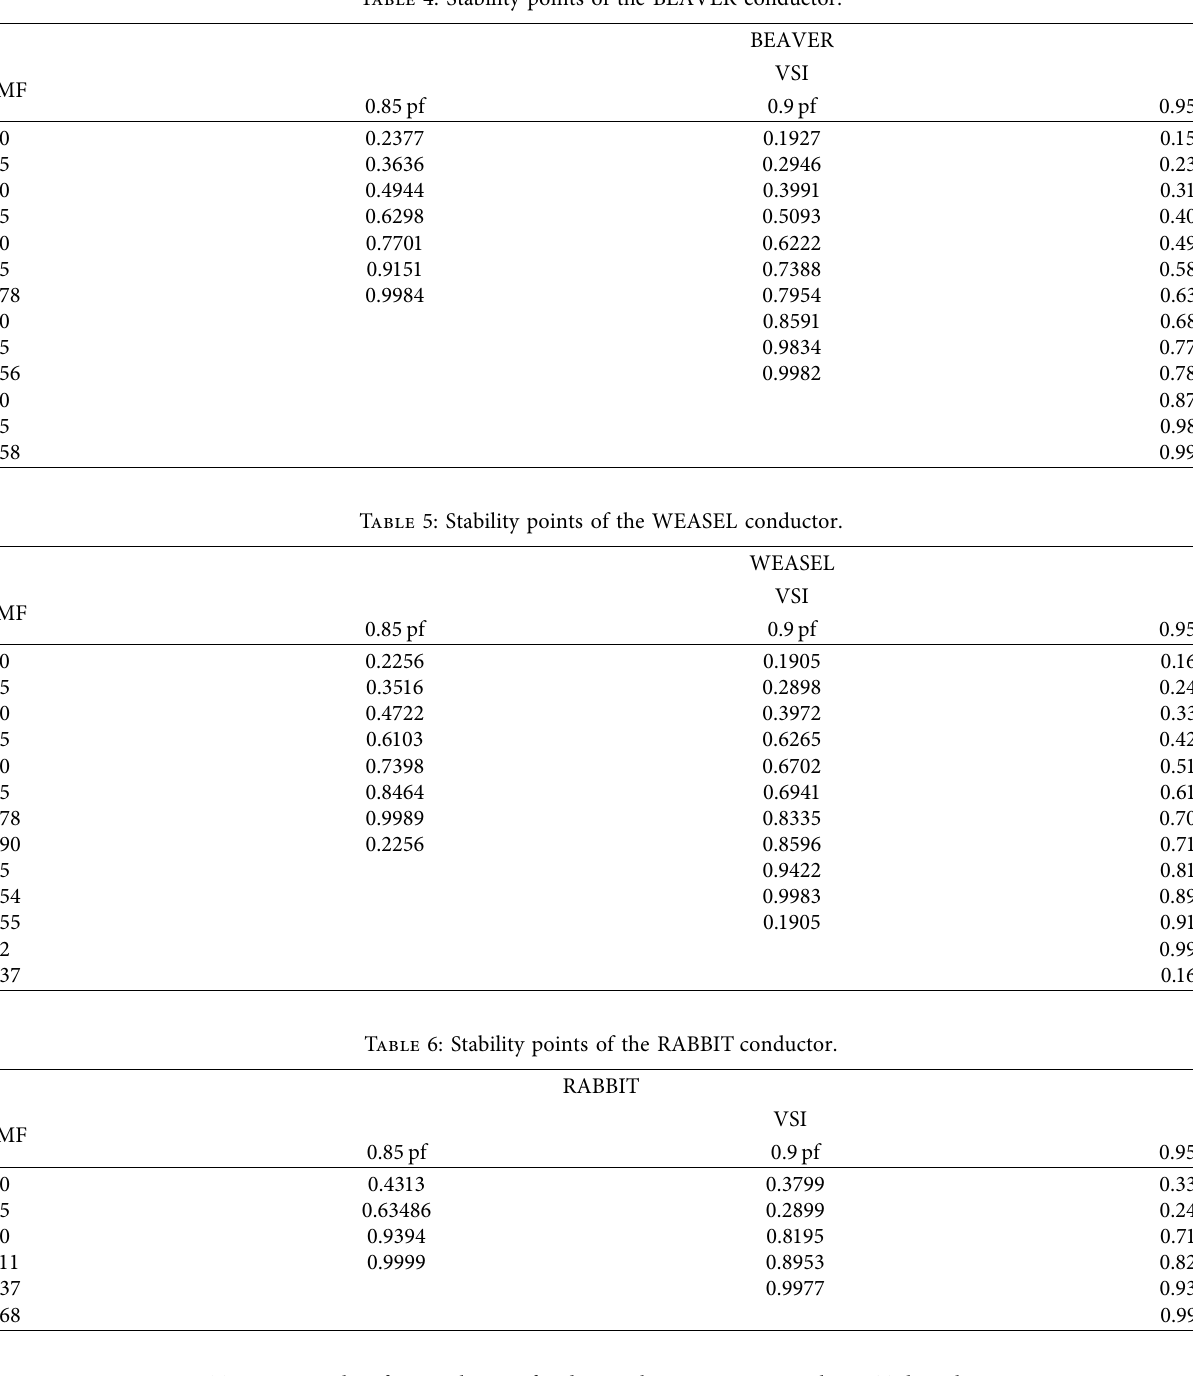
Table 7: Results of power losses of Indian 62 bus systems using the BAT